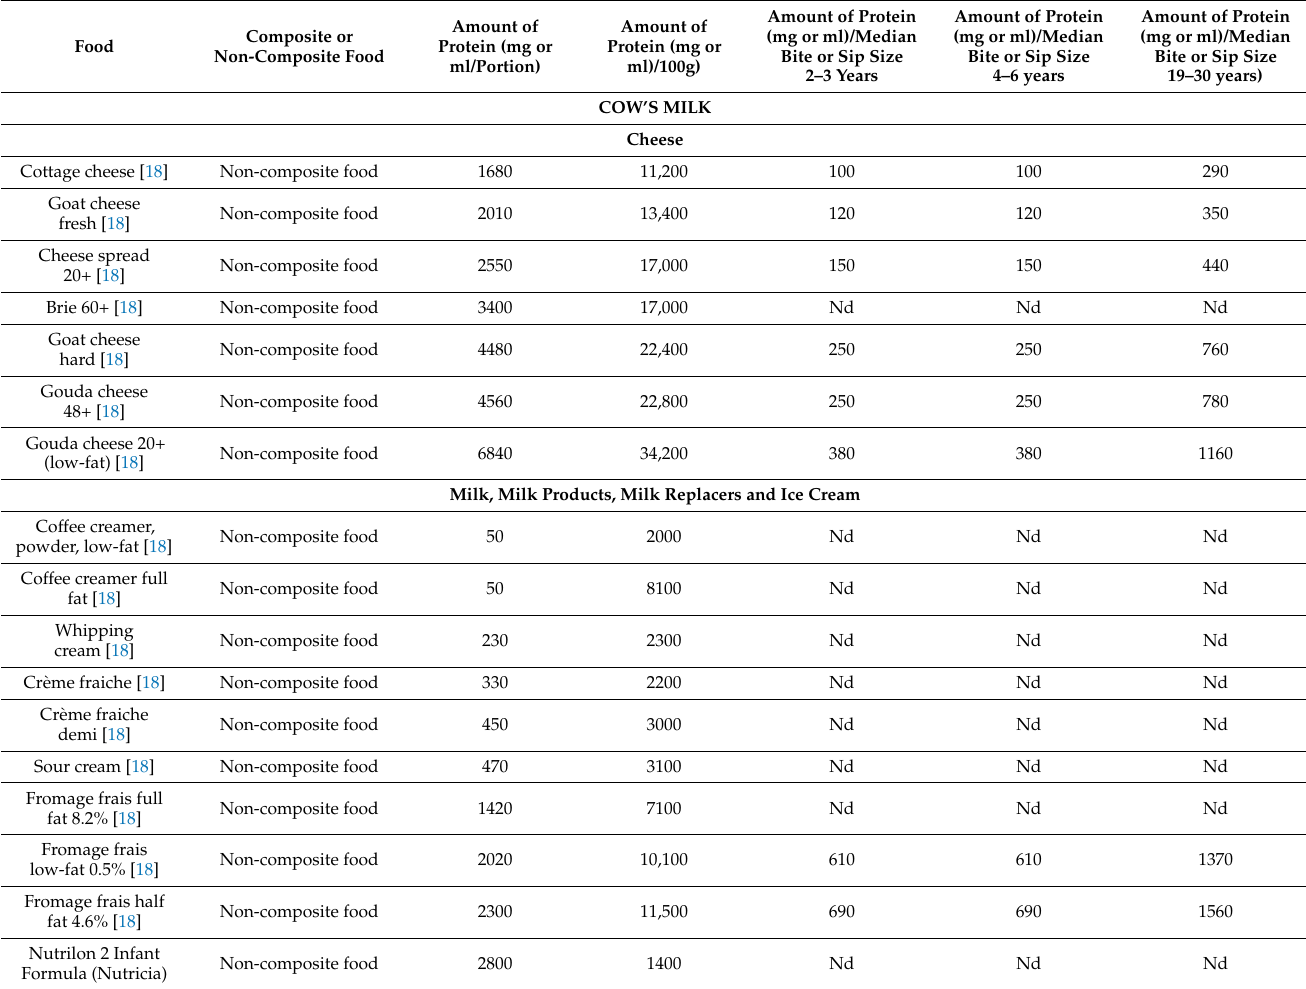
Table 1. Amount of estimated allergenic protein in most frequently consumed non-composite foods in mg or ml per portion, mg or ml per 100 g and mg or ml per median bite or sip size in different age